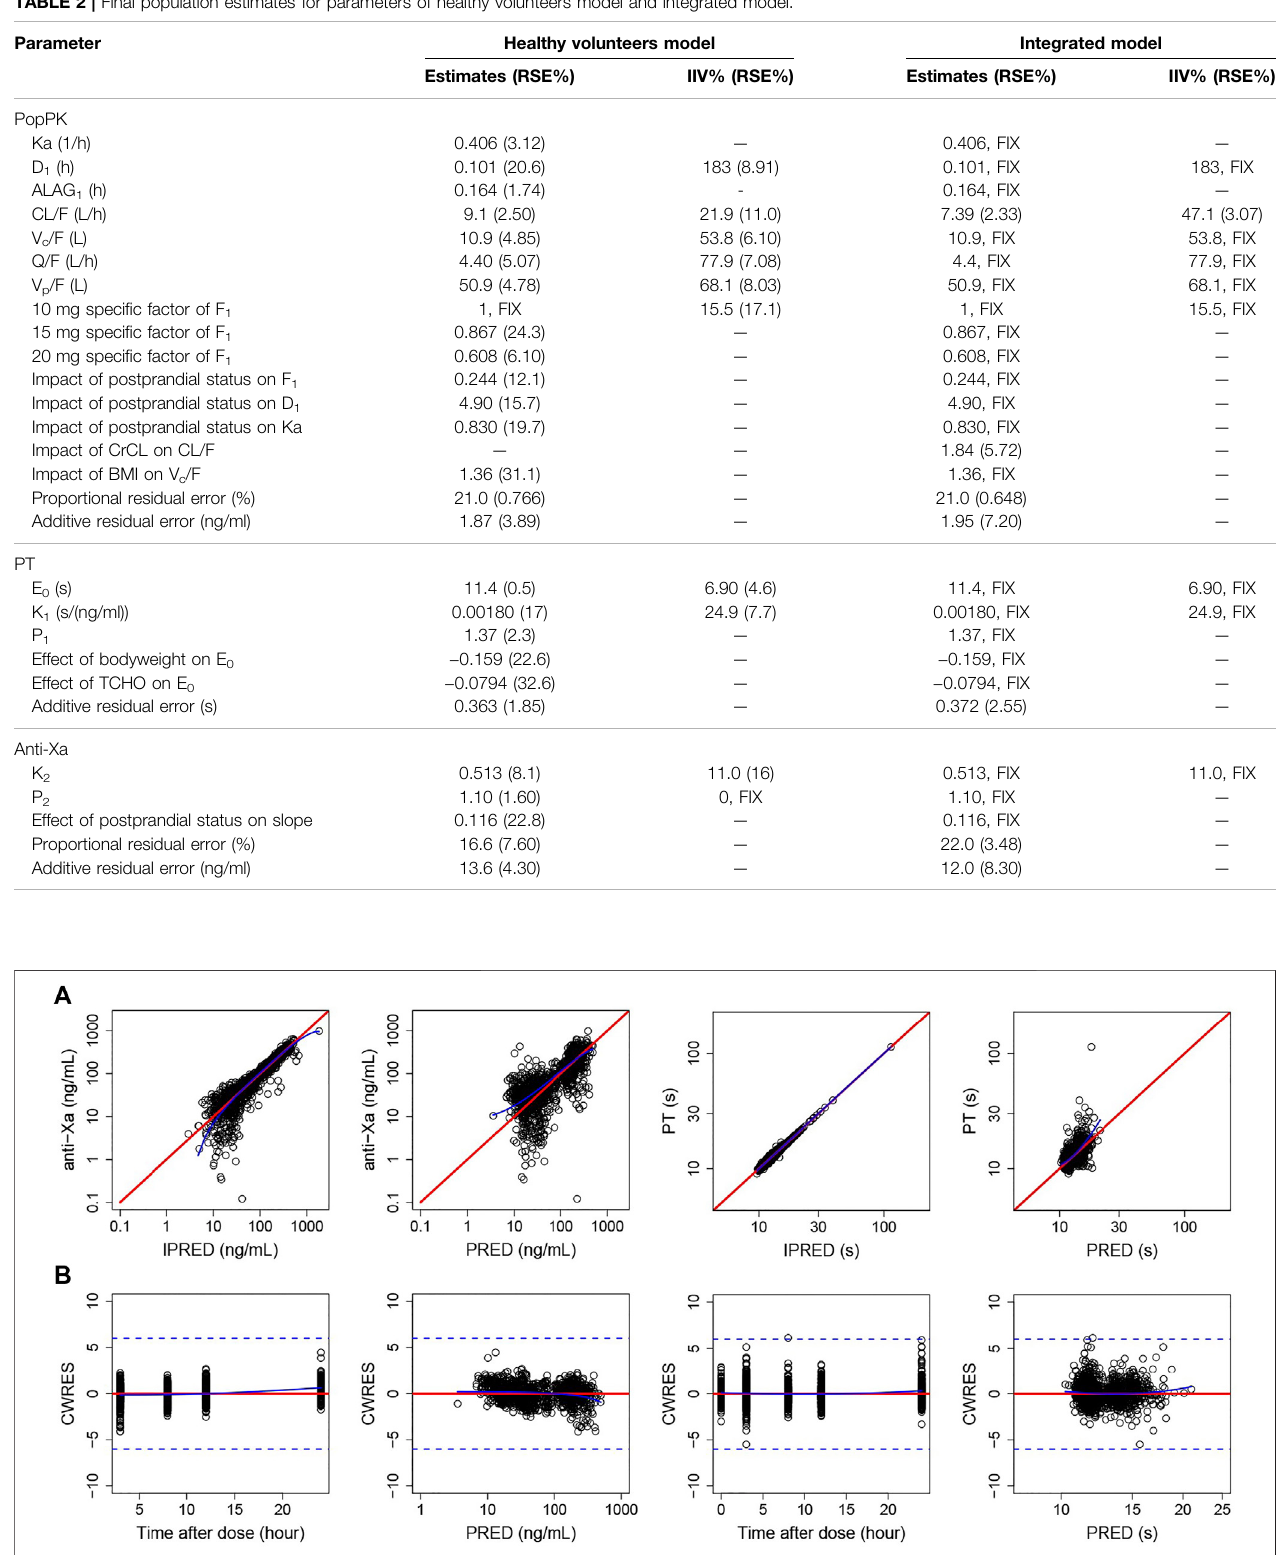
Frontiers in Pharmacology |